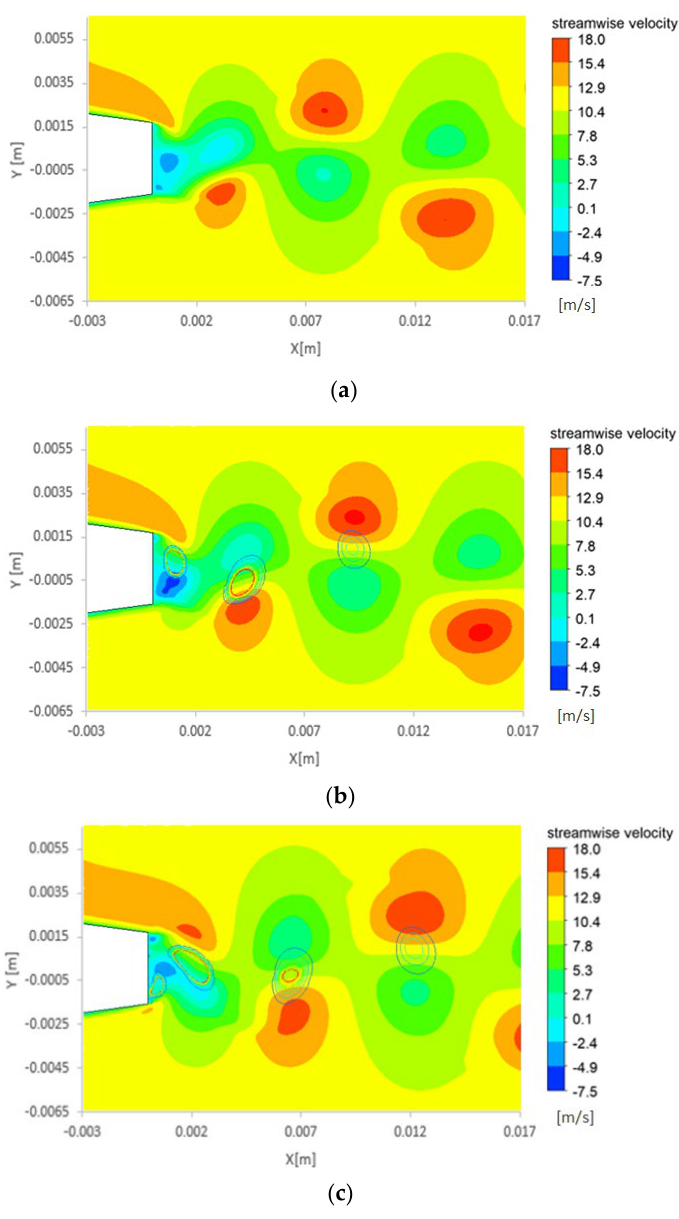
( a ), = 2 ( a ), σ i 𝜎𝜎 𝜎𝜎 𝑖𝑖 = 2